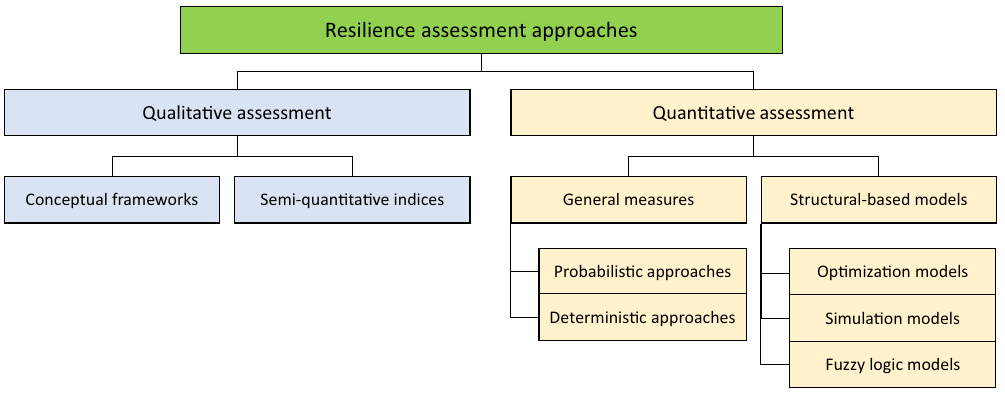
Figure 2. Classification of resilience assessment methodologies (redrawn from Ref. 30